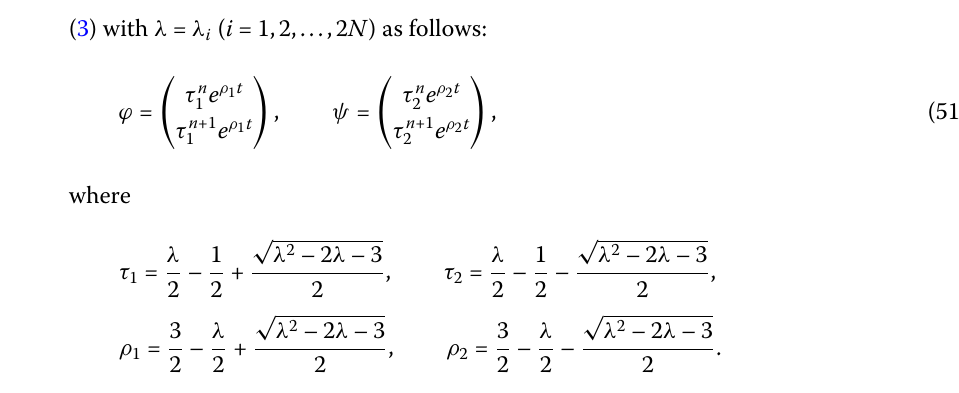
, λ 3 = –2, λ 4 = – 3 . ( a ) Exact solution; ( b ) Time evolution using exact solution 2 2